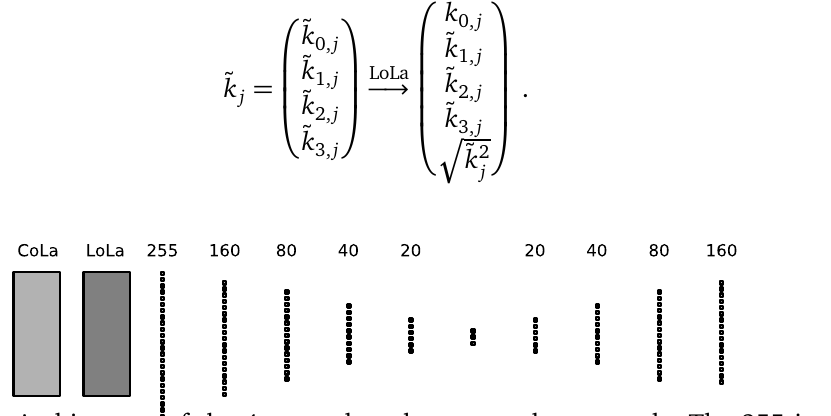
Figure 3: Architecture of the 4-vector-based autoencoder network. The 255 input units correspond to 55 L O L A -vectors with 4 + 1 entries each. The output only con- sists of 160 units, because the extended 4-vectors only carry four independent ob-